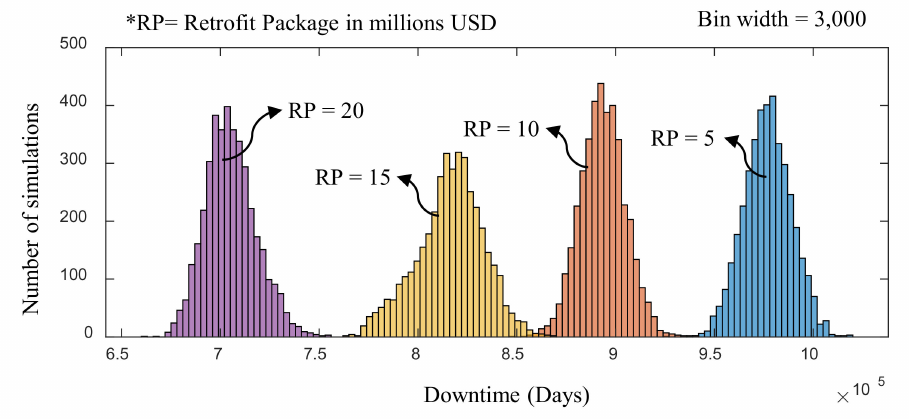
Figure 13. Distributions of risk performance indicator under four retrofit programs.